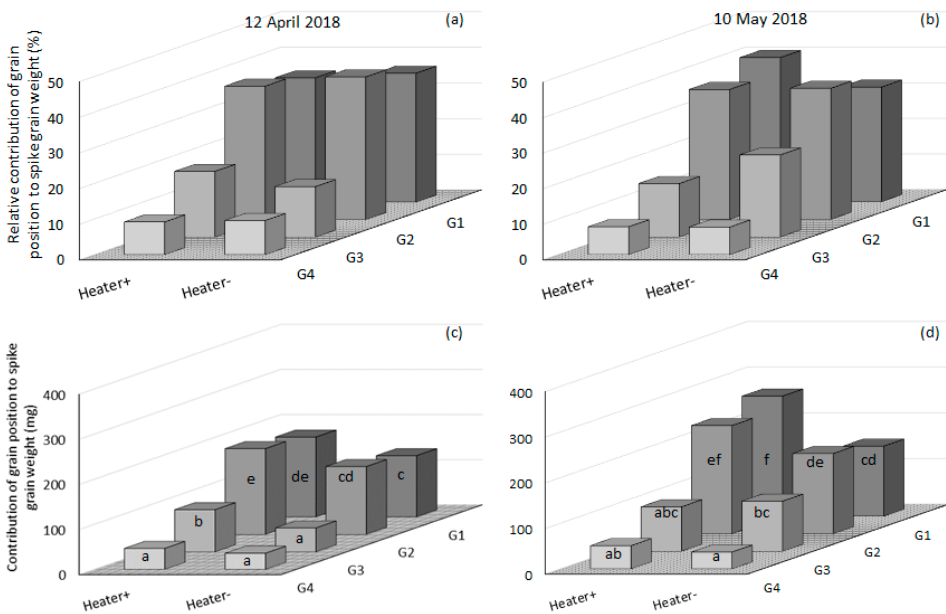
Figure 12. The relative contribution of grain at each position of the spikelet (grain position) to spike grain weight in Wyalkatchem sown in mid-April (12 April 2018 ( a )) and mid-May (10 May 2018 ( b )) sampled from heated and frosted non-heated plots. Absolute spike grain weights for the same sowing dates are shown on ( c , d ) with significance ( p < 0.05) noted by letters with each sowing date compared separately. Relative contributions are calculated from the predicted means of absolute spike grain weights (n = 45 spikes per data column).